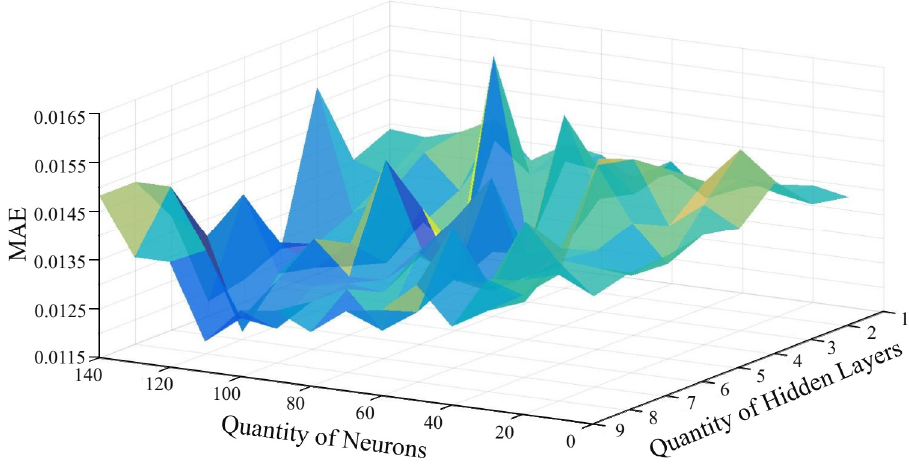
Figure 5. The result of grid search method for determining hidden layers and neurons.